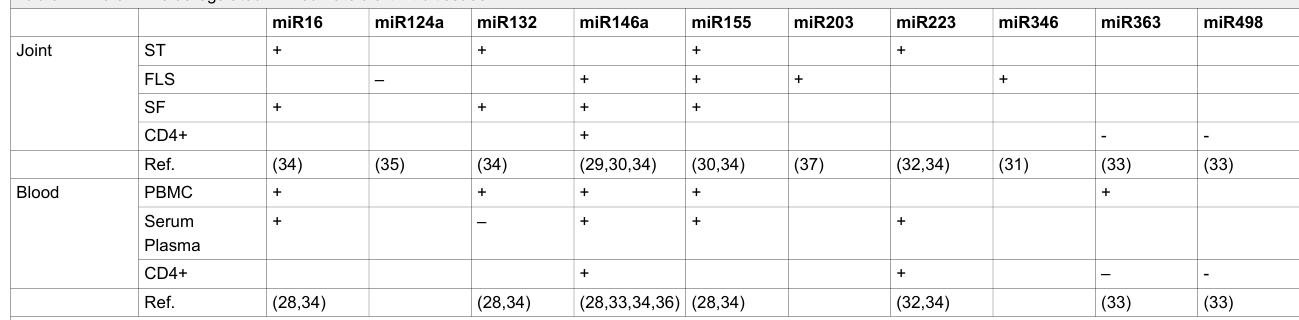
Table 1: microRNAs deregulated in rheumatoid arthritic tissues.